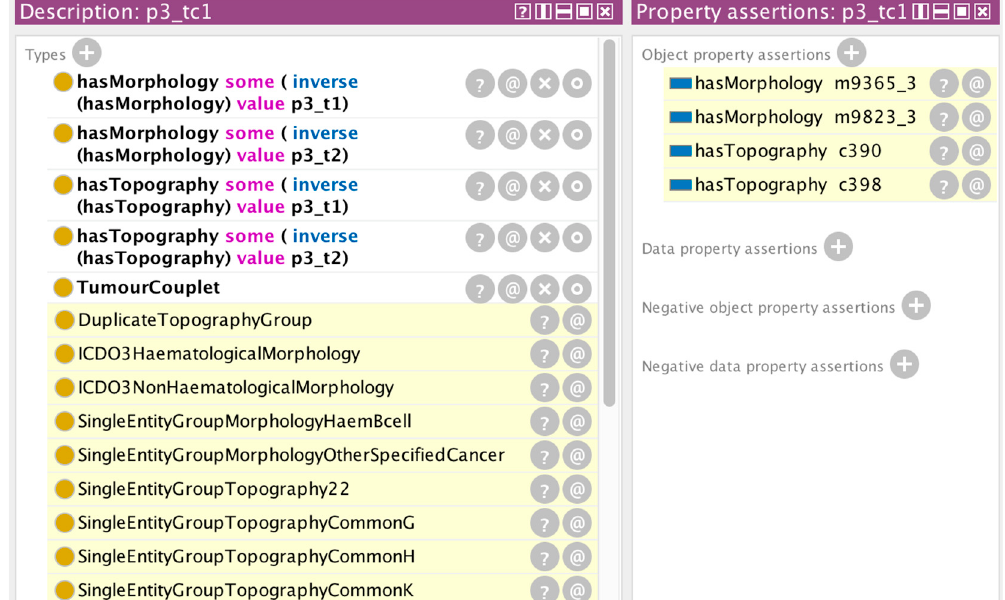
Figure 7. Results of the reasoning operation for the tumour couplet p2_tc1. Only the topography codes are equivalent and the couplet is a valid MPT.